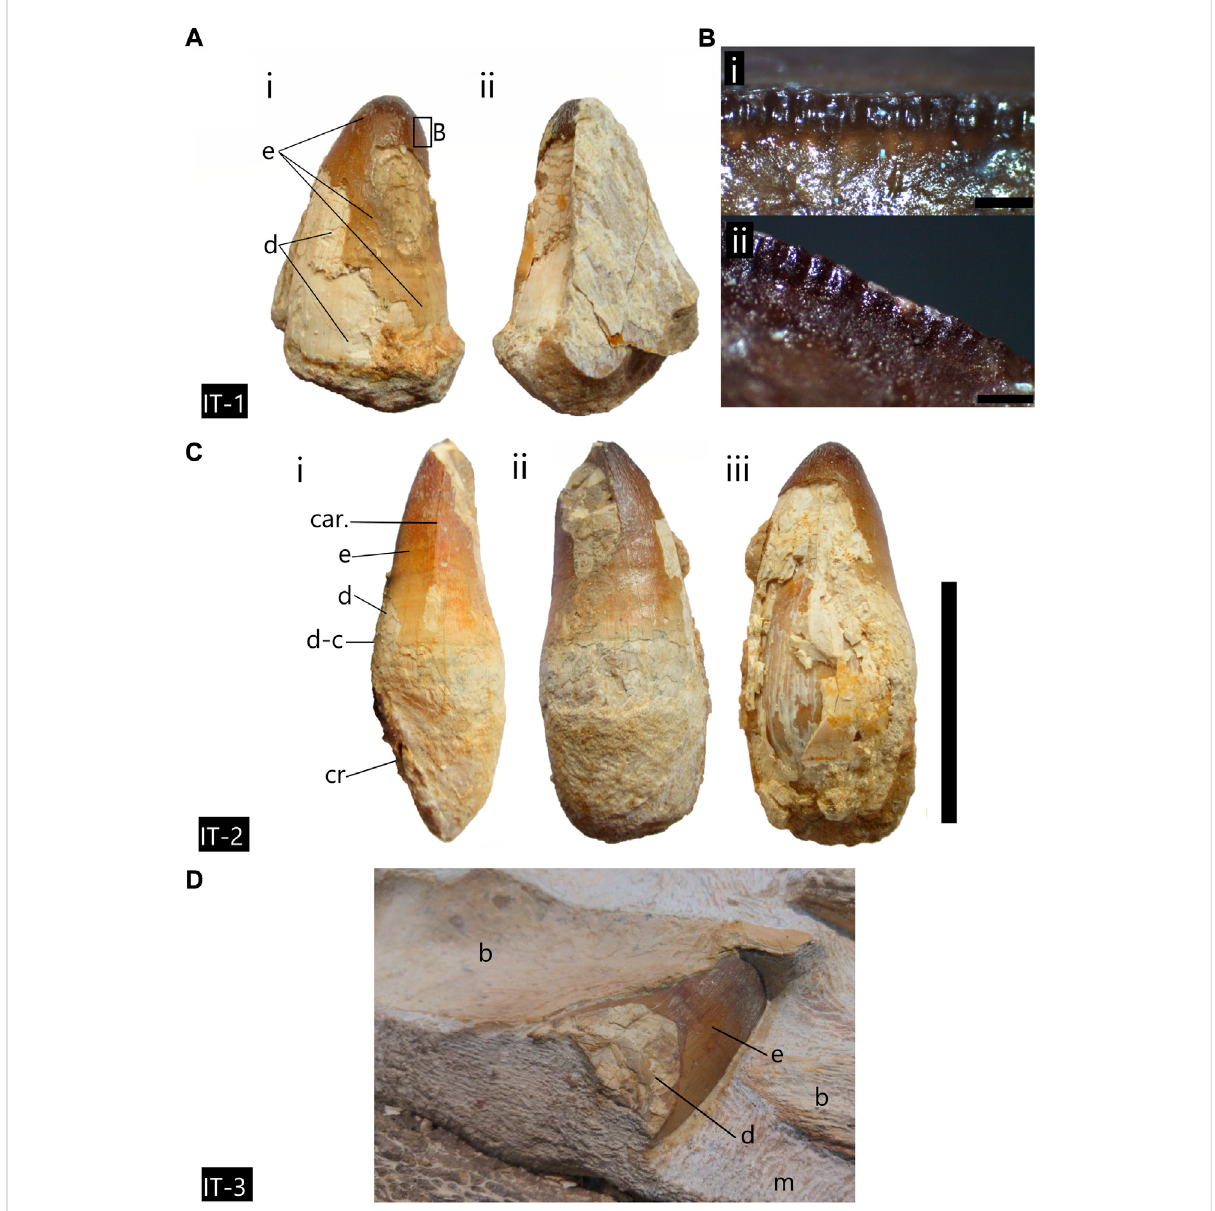
FIGURE 6 Fragmentary, isolated teeth, from cf. Prognathodon muzzle unit (CGP/1/2265). (A) Isolated tooth 1 (IT-1) in (i) labial and (ii) lingual view. Only enamel crown present. Enamel and dentine portions indicated. (B) IT-1 fi ne serrations visible on anterior and posterior carinae. (C) Isolated tooth 2 (IT-2)in (i) posterior, (ii) lingual and (iii) labialview. (D) Isolatedtooth3(IT-3)partiallyvisible,wedged beneathnasalcavity fl oorboneandsurrounded by matrix. Abbreviations: car., posterior carinae; e, enamel; d, dentine, d-c, dentine-cementum contact; and cr, cementum root is indicated. Scale bars (A) = 50 mm; (Bi) = 1 mm, (Bii) = 0.5 mm; (C) = 90 mm; (D) = no